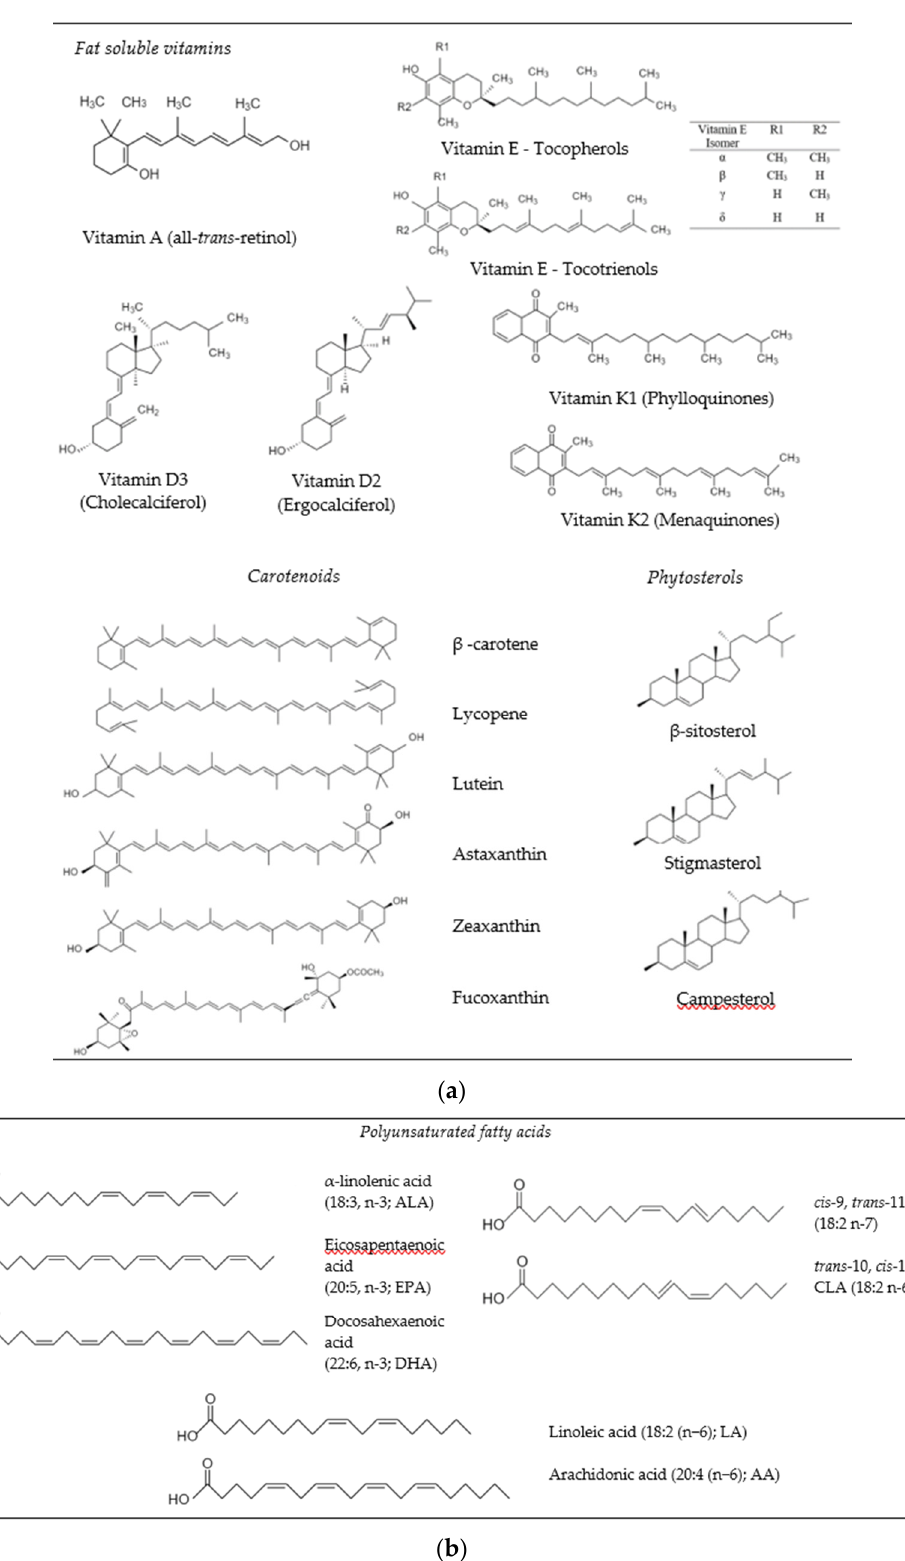
Figure 1. Chemical structures of bioactive lipids: ( a ) fat soluble vitamins, carotenoids, phytosterols, ( b ) polyunsaturated fatty